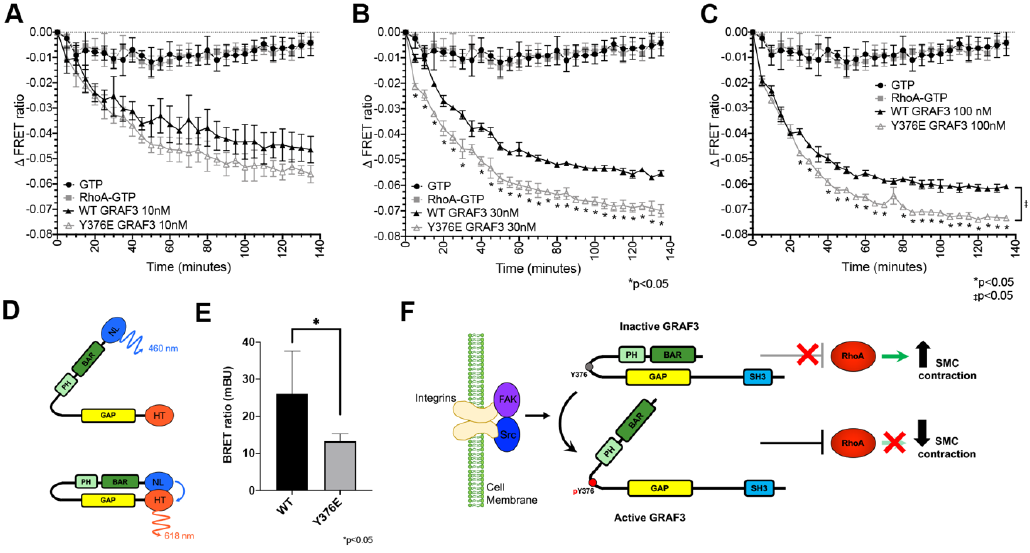
Figure 5. Phosphorylation of GRAF3 at Y376 increases GAP activity in vitro and decreases RhoA activity in SMC. TR-FRET GDP assay was performed using ( A ) 10 nM, ( B ) 30 nM and ( C ) 100 nM purified WT or Y376E GRAF3 BAR-PH-GAP variant. A decrease in signal indicates an increase in GTP to GDP conversion; n = 3, * p < 0.05 between WT GRAF3 and Y376E GRAF3 at indicated timepoints, as assessed by unpaired t-test. Although not depicted, * p < 0.05 at all points except zero for both WT GRAF3 or Y376E GRAF3 compared to either GTP or RhoA-GTP. GTP vs. RhoA GTP is not significant. One-phase decay linear regression revealed significance ( ‡ p < 0.05) between the slopes of WT GRAF3 and Y376E GRAF3 at 100nM. ( D ) Schematic of GRAF3 BRET activation probe NL, NanoLuc. HT, HaloTag ( E ) GRAF3 WT vs. GRAF3 Y376E BRET activity in SMC. n = 6. mBU, miliBRET units. ( F) Model of GRAF3 activation by Src or FAK phosphorylation of GRAF3 at Y376.